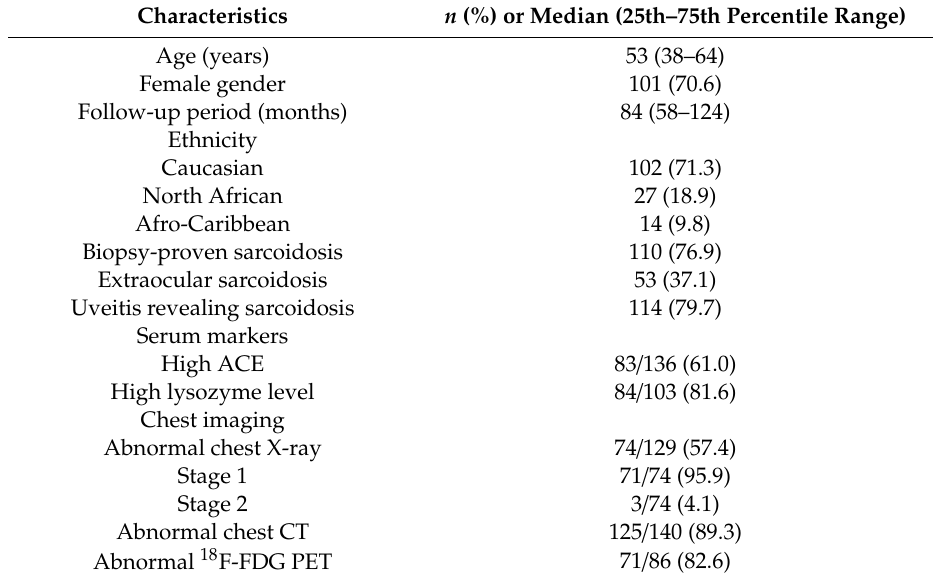
Table 1. General characteristics at diagnosis of the 143 patients with sarcoid uveitis. Characteristics